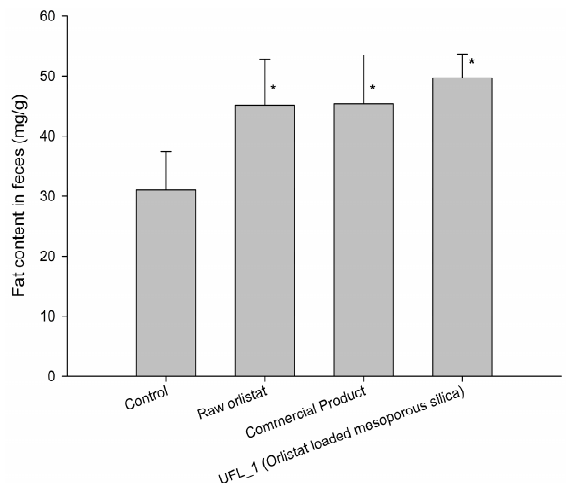
Figure 10. Effects of raw orlistat, the commercial product, and UFL_1 on fat excretion in feces of mice fed a high-fat diet for 5 days. *: p < 0.05, vs. control.